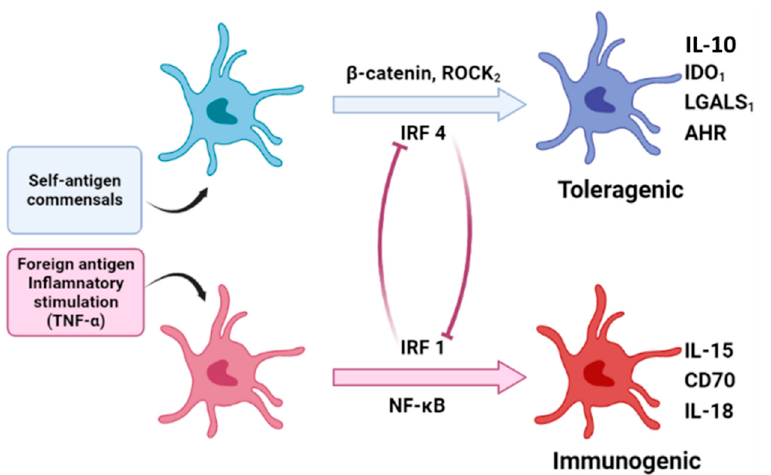
Figure 3. Schematics for the proposed functional plasticity. Left penal showed the heterogeneity of LC and the development of tolerogenic and the immunogenic of LC, which could be susceptible to different environment factors. Middle panel showed the different signaling pathways mediated the activation and the counter-regulatory role of different types of LC. Right panel showed the molecular mechanisms used by LC to induce tolerogenic or immunogenic immune